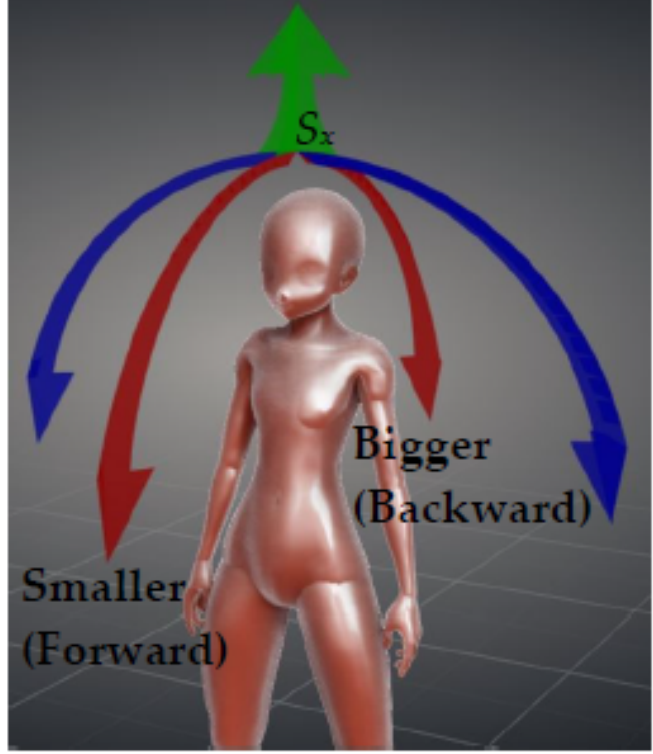
Figure 19. Diagram showing the correction of posture standard